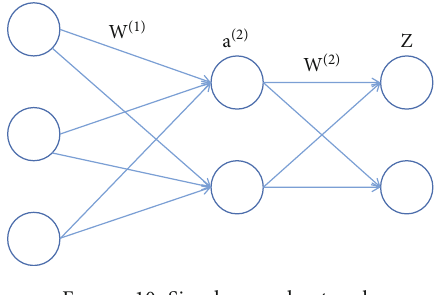
Figure 10: Simple neural